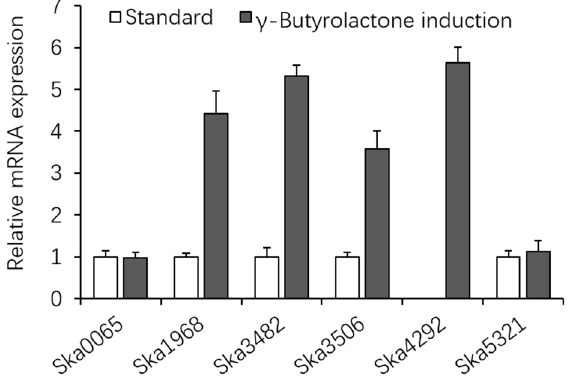
Figure 2. Expression difference of PKS and NRPs genes in S. kanasensis ZX01 after γ -butyrolactone induction for 72 h. Ska0065, Ska1968 and Ska3482 are type-I PKS; Ska4292 is type-III PKS; Ska3506 and Ska5321 is NRPs.